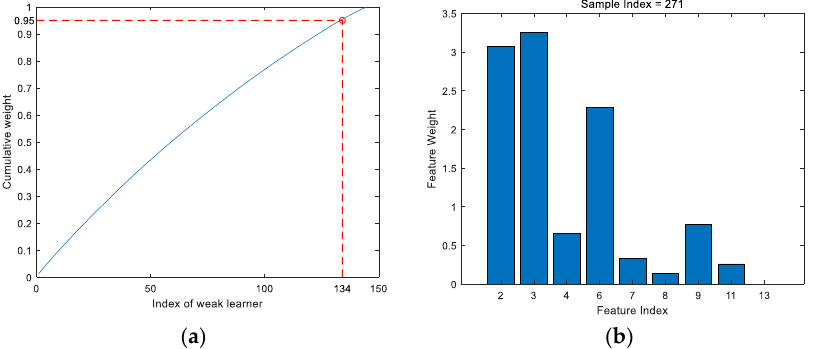
Figure 6. ( a ) Weight cumulative curve for ranked weak learners; ( b ) feature weight of the sample index of 271.